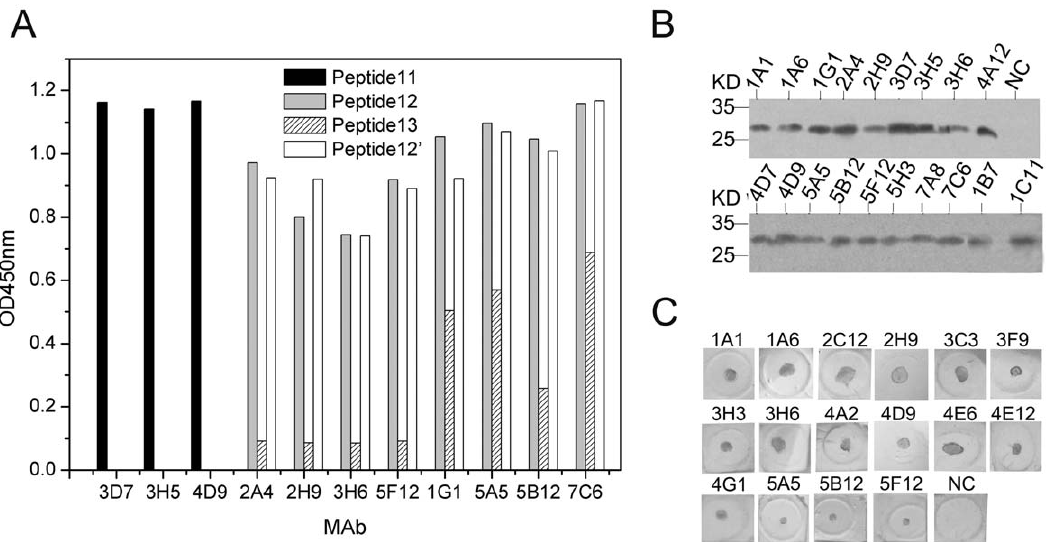
Figure 1. Reactivity of mAbs to 16mer peptides and native BP26 containing membrane protein extracts of B.melitensis M5-90. (A) Bindings of mAbs to 16mer overlapping peptides in Peptide-ELISA. Twenty nine of 16mer overlapping peptides spanning the entire sequence of BP26 were coated to the plates with 5 m g/ml in CBS buffer (pH 9.6). The peptides bound plates were tested with 29 mAb supernatants of hybridomas. An HCV NS3 peptide coated wells were used as negative-controls. Cut off was defined above 2.1 folds of OD value to negative control. The dot line indicates the level of cut off. (B) Reactivity of mAbs to the SDS denatured native BP26 of NMP in Western-Blot. (C) Reactivity of mAbs to non-denatured native BP26 of NMP in Dot-ELISA. NC, a negative control of an un-related mAb to HCV rNS3.